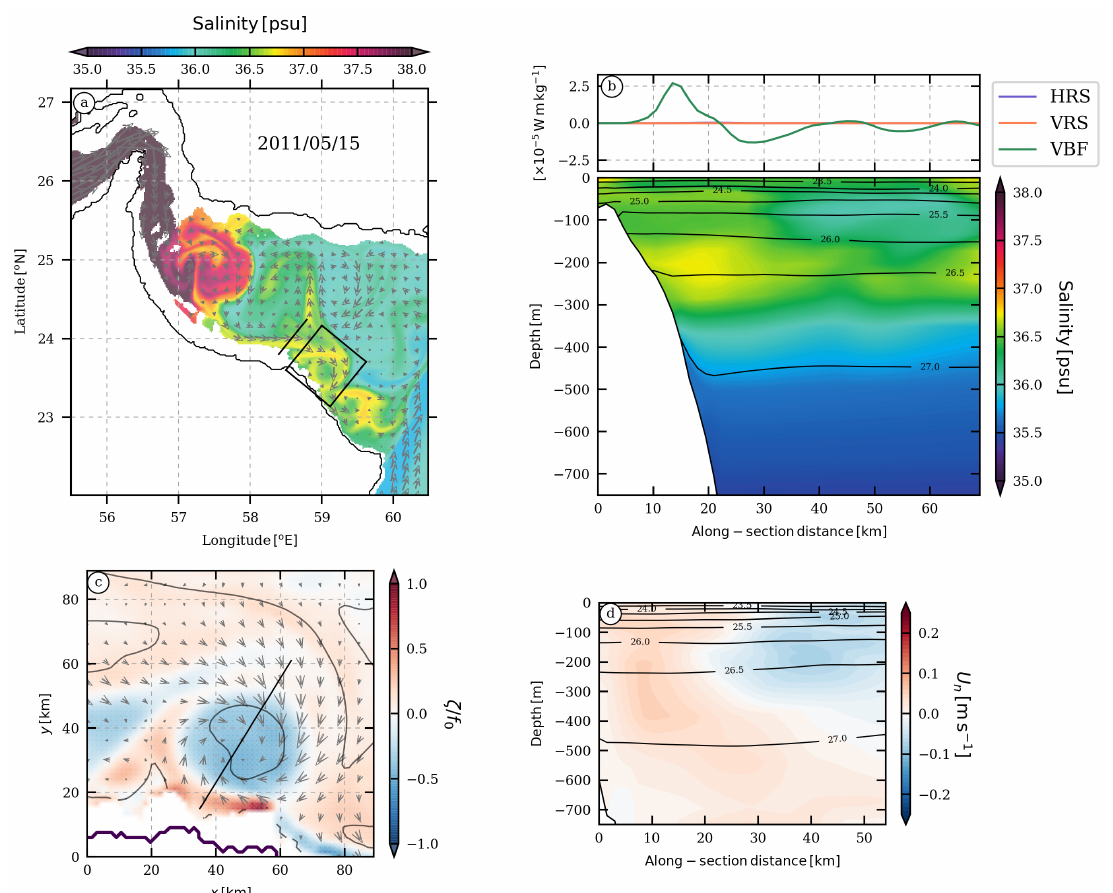
Figure 11. ( a ) Instantaneous salinity interpolated on the σ 0 = 26.5kgm − 3 density level in the Gulf of Oman. Arrows stand for the velocity vectors interpolated on the same density level. ( b , top ) Energy conversion terms integrated from the surface down to 100 m depth, and timely averaged over 20 days centered at the date indicated in ( a ): horizontal Reynolds stress (HRS, in blue), vertical Reynolds stress (VRS, in orange), and vertical buoyancy flux (VBF, in green) in the along-section direction (see solid black line in ( a ) for location). ( b , bottom ) Vertical slice of salinity (see solid black line in ( a ) for location). Density contours are represented as solid black lines. ( c ) Zoom in the Gulf of Oman (see black squared box in ( a ) for location) over a submesoscale anticyclone near the southern coast. Vertical relative vorticity normalized by the Coriolis frequency averaged over the region ( f 0 ) interpolated on the σ 0 = 26.5kgm − 3 density level. Arrows stand for the velocity vectors interpolated on the same density level. ( d ) Vertical slice of the normal velocity (see solid black line in ( c ) for location). Density contours are represented as solid black